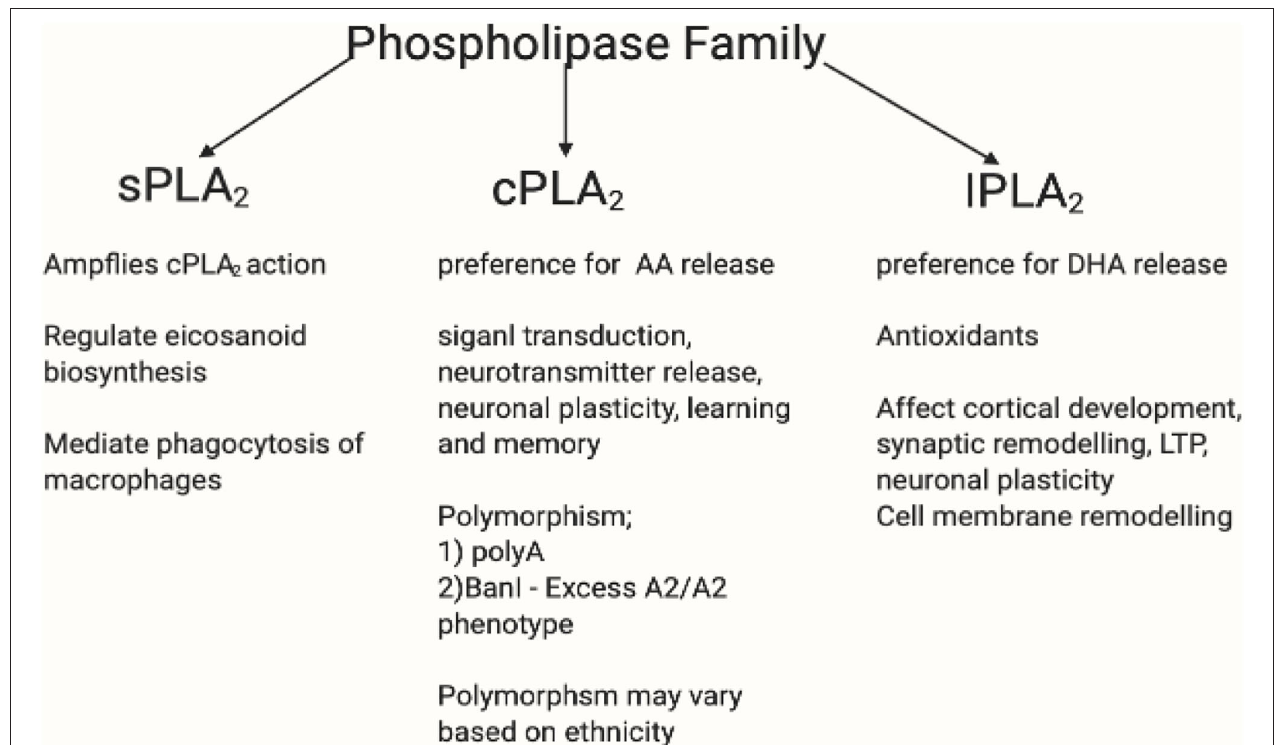
FIGURE 9 | This figure shows the PLA 2 family profile. The phospholipase A 2 superfamily consists of enzymes that catalyse the hydrolysis of (sn-2) ester bond of phospholipid to liberate free fatty acids such as AA ( 254). The family of PLA 2 consists of secretory calcium dependent PLA 2 (sPLA 2 ), intracellular calcium